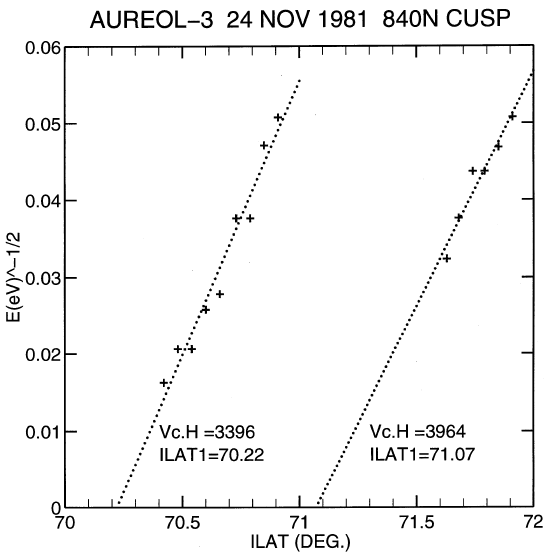
Fig. 3. Inverse root square of the ion energy, E of the invariant latitude ILAT (degrees), for the two ion energy- latitude dispersion events observed on pass 840. The dotted lines are the linear least square fits to the form (1), with the fit parameters given for each line